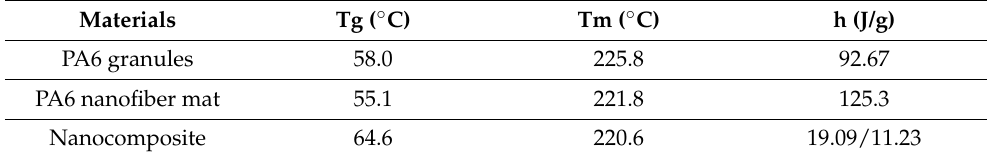
Figure 9. Differential scanning calorimetry (DSC) of the PA6 granules, PA6 nanofiber mats, and the nanocomposites. Table 2. The thermal properties of the PA6 granules, electrospun PA6 nanofibers, and the nanocomposites. Materials